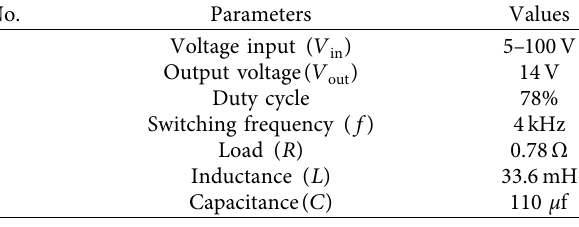
Table 1: Parameter setting for a buck-boost converter.